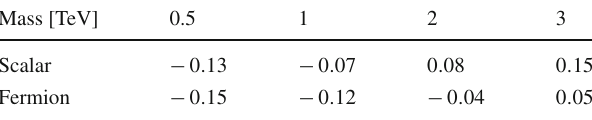
Table 3 (σ inc − σ exc )/σ exc for scalars and fermions with Q = 8